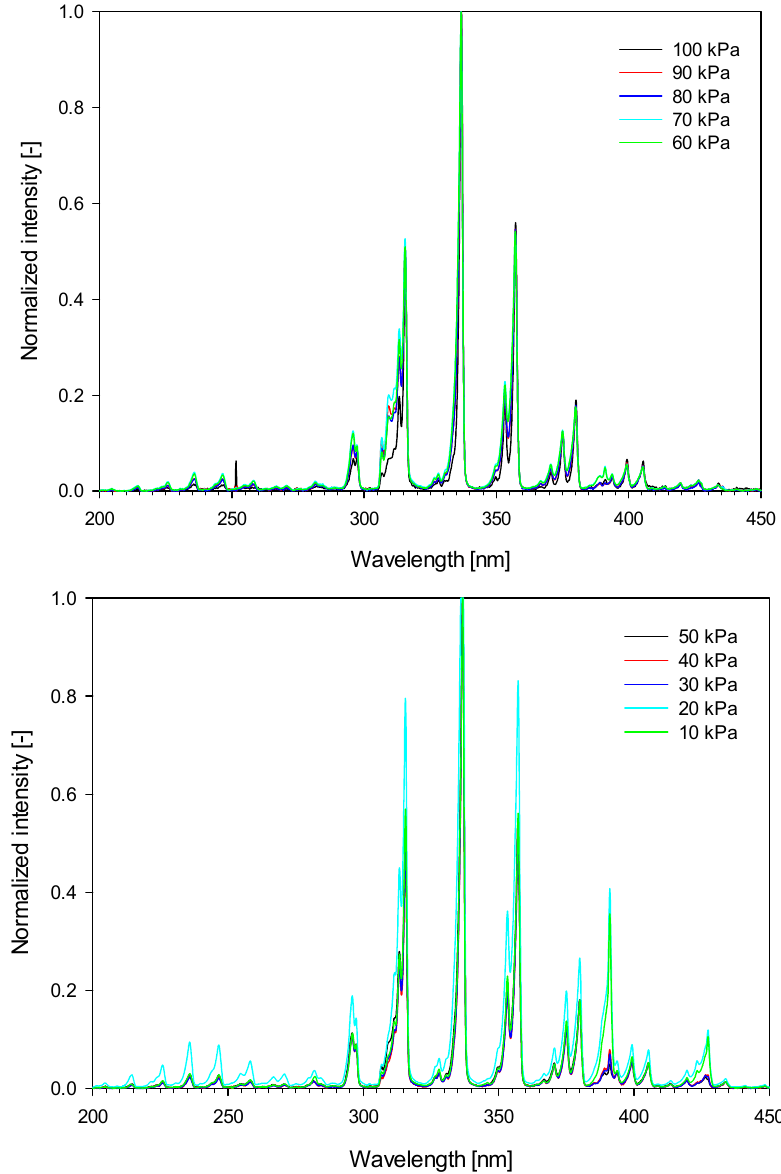
Figure 7. Normalized spectra of the electric arcs with ac supply in the 100–10 kPa pressure range using a needle-plane gap (diameter = 1.0 mm, gap = 30 mm).